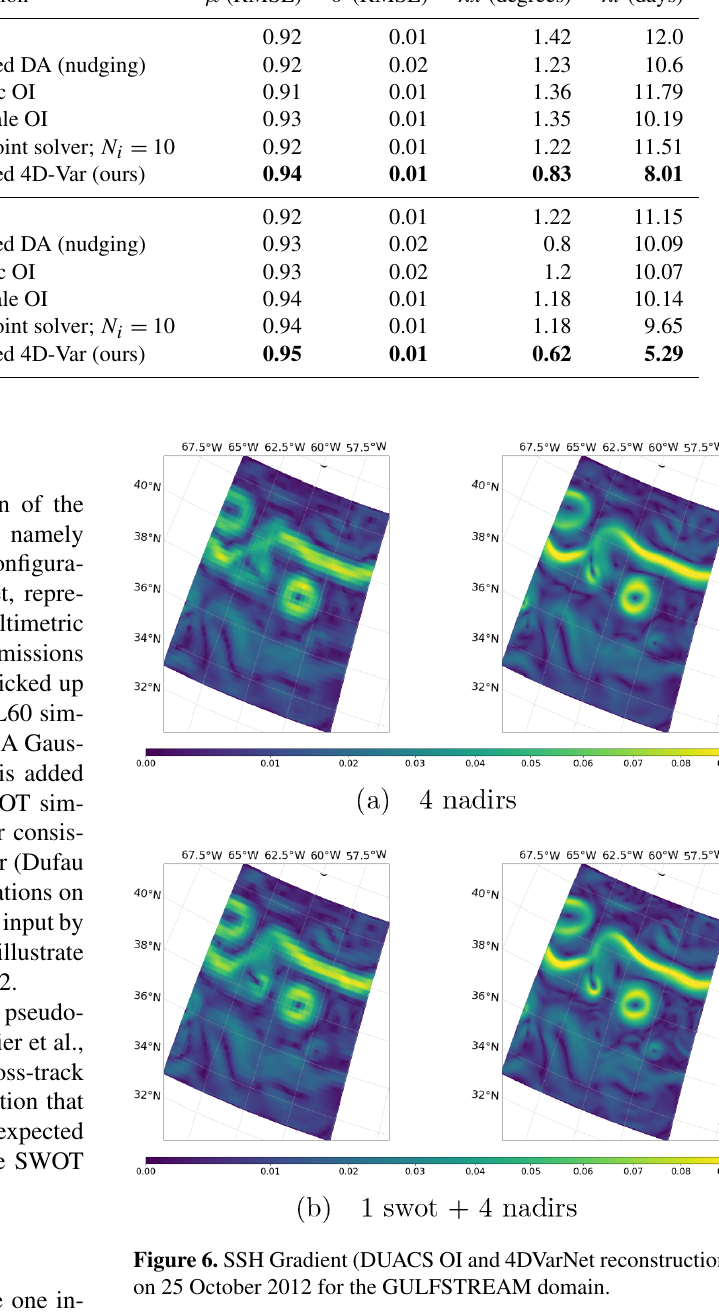
using the time period from 4 February to 30 Septem- ber 2013. During the training procedure, we select the best model according to the metrics computed over the validation period from 1 January to 2 February